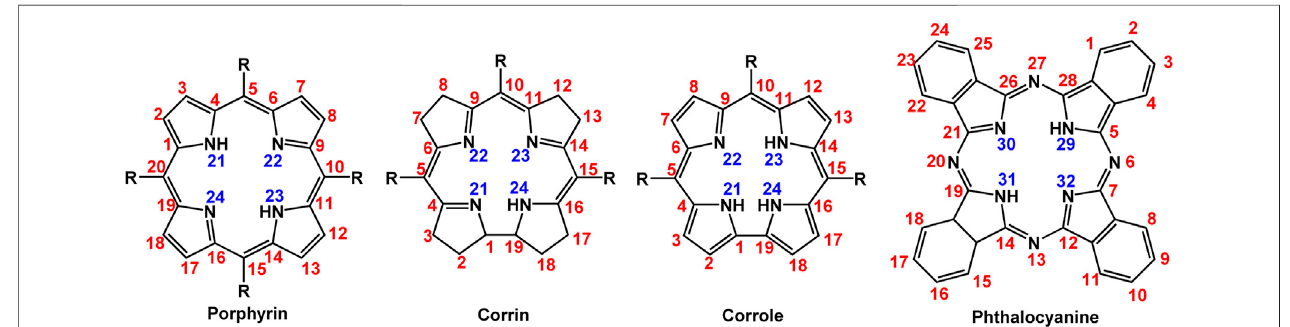
FIGURE 1 | General structures of tetrapyrrole